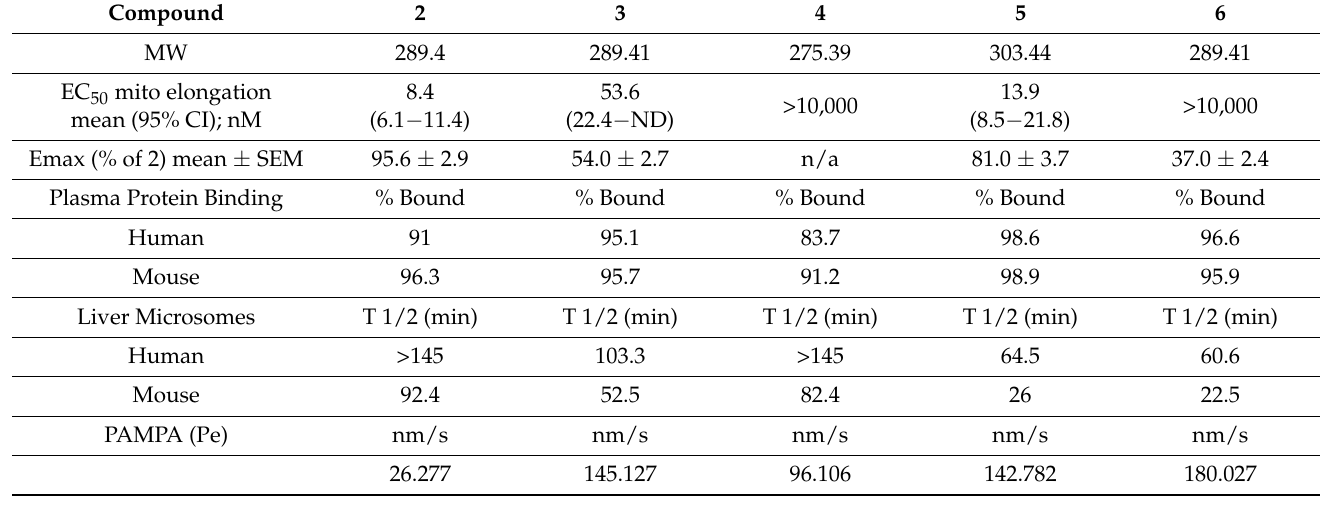
Figure 5. Modulation of mitochondrial fusion by piperidine derivatives . ( A ) Results of mitochondrial elon- gation screening assays performed in Mfn2-null MEFs using 1 μ M of each piperidine derivative. ( B ) Concentration-dependent mitochondrial elongation of active compounds in Mfn2-null MEFs. EC 50 with 95% CI and E max values are in Table 2. * = p < 0.05 vsVeh.